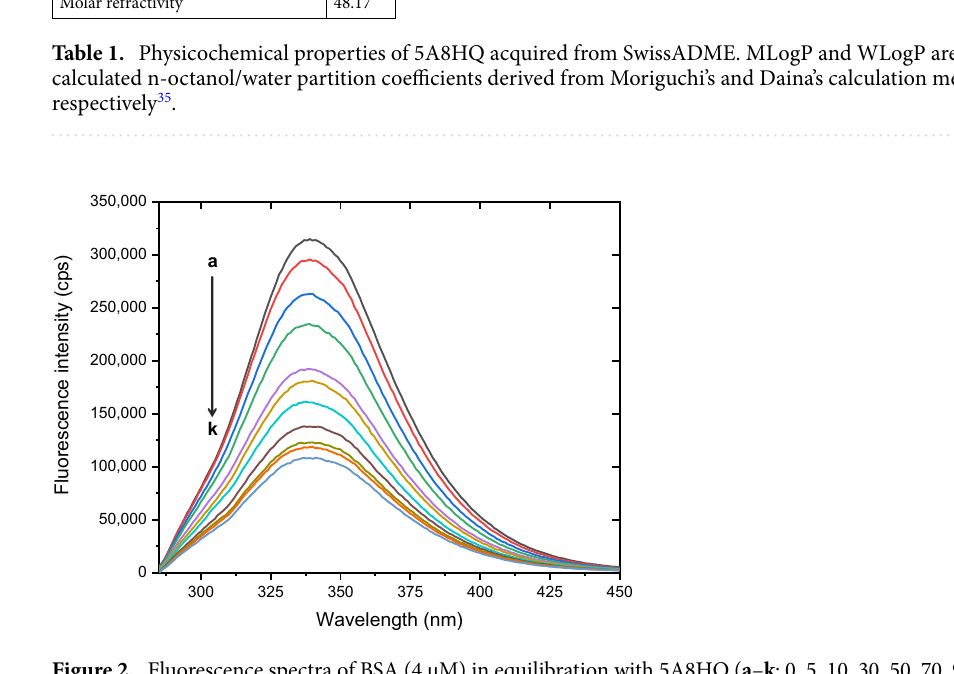
Figure 2. Fluorescence spectra of BSA (4 µM) in equilibration with 5A8HQ ( a – k : 0, 5, 10, 30, 50, 70, 90, 110, 130, 150, and 170 µM) upon excitation with 280 nm ray length at 310